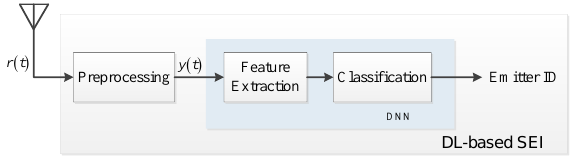
Figure 3. Implementation Framework of DL-based SEI.